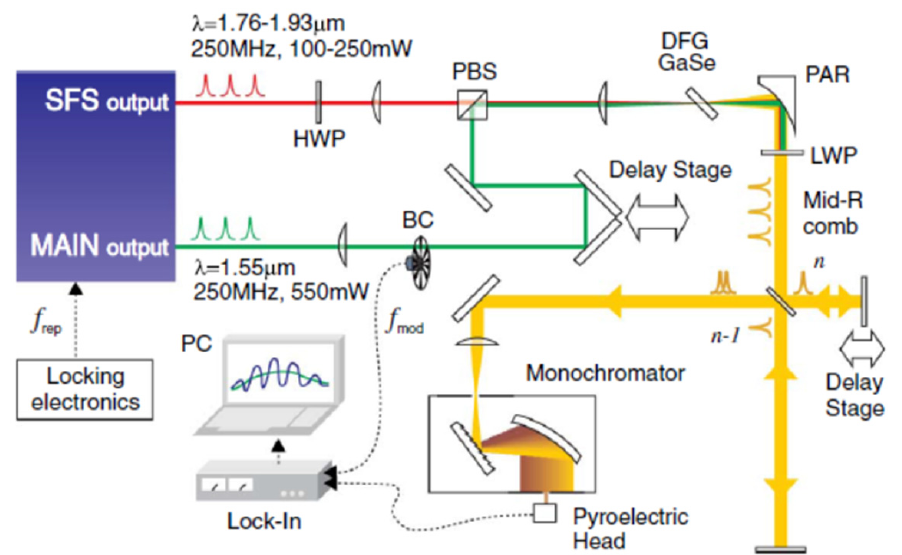
Figure 5. The 8–14 µm tunable MIR laser pulse generation. Reprinted with permission from [111] © The Optical Society. The experimental setup used for the mid-IR comb generation is based on a commercial dual-branch Er: fiber laser oscillator. The main output provides 1.55 µm, 550 mW, and 50 fs pulses, which are used as pump pulses. The second output produces tunable SFS solitons (as short as 84 fs) in the range 1.76–1.93 µm with an optical power varying from 100 to 250 mW by coupling pulse into a nonlinear Raman fiber, which are used as signal pulses.